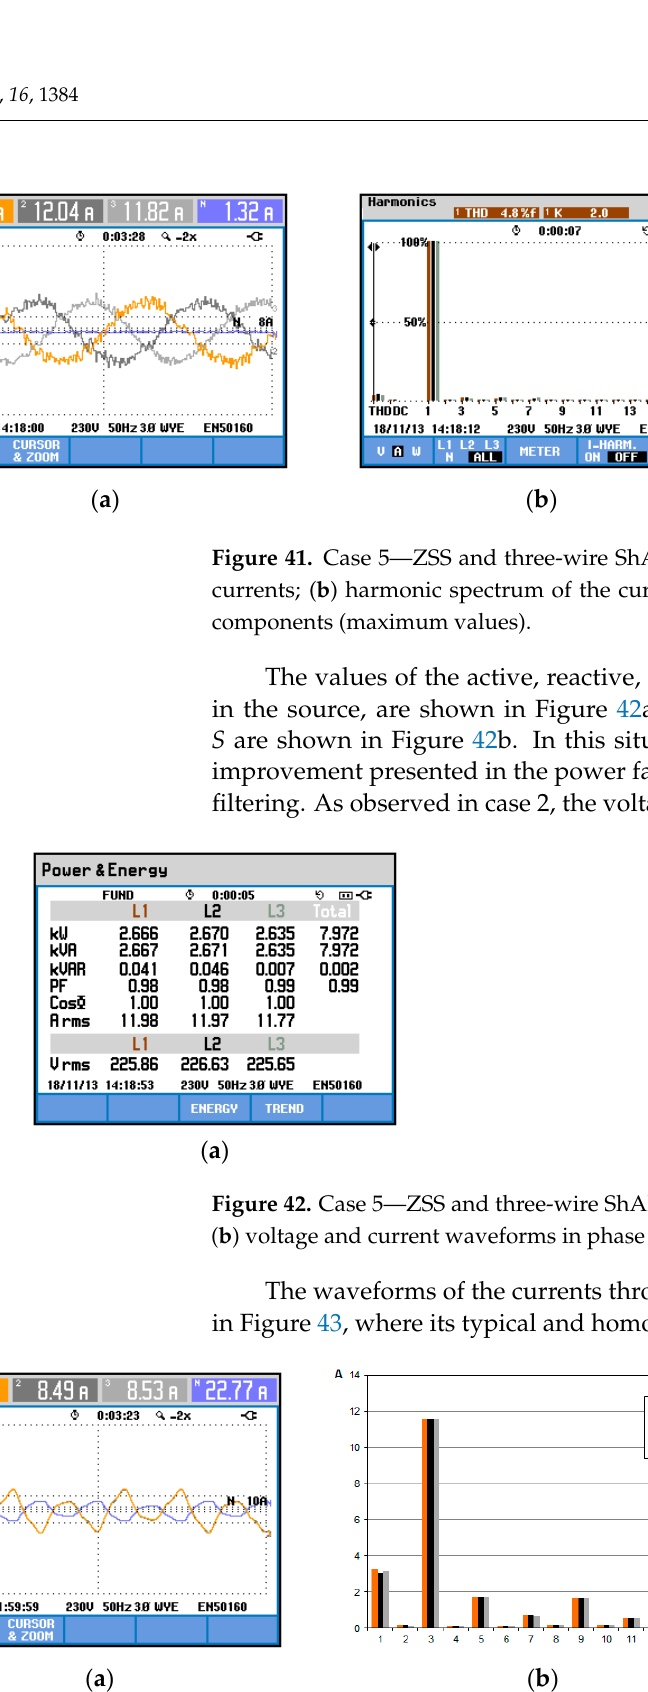
( b ) Figure 39. Case 4 - without filters with unbalanced loads: ( a ) source power; ( b ) voltage and current waveforms in phase S . V.